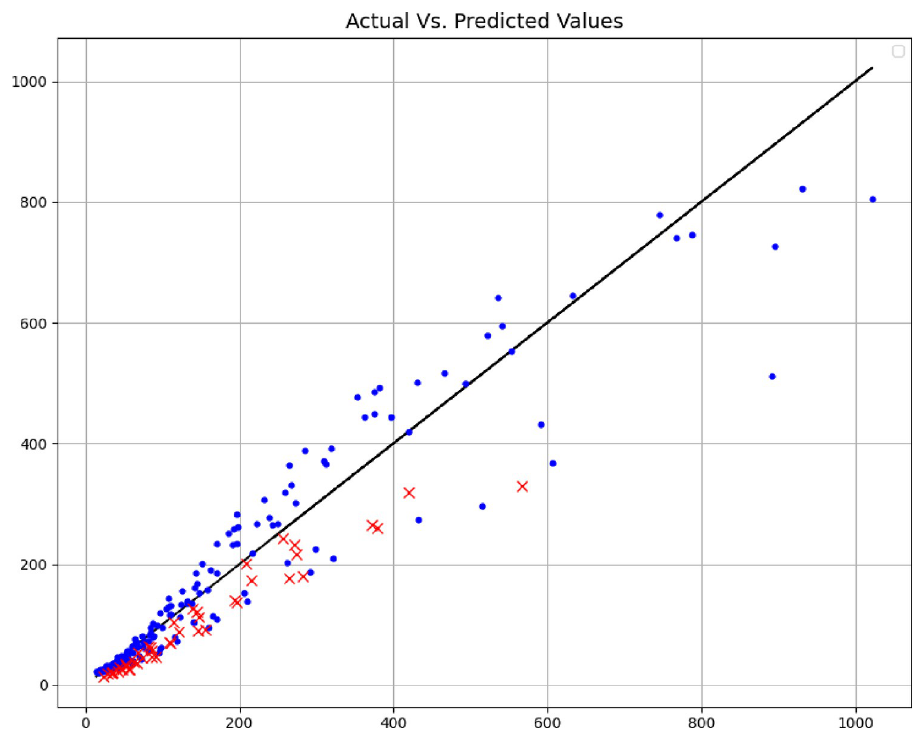
Fig 4. Actual Vs. estimated outputs (DT model).